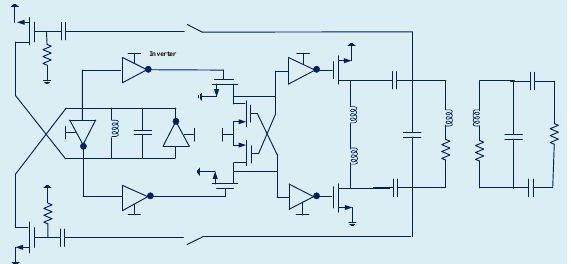
Figure 5. A WPT system with combined Tx design to achieve maximum power transfer.